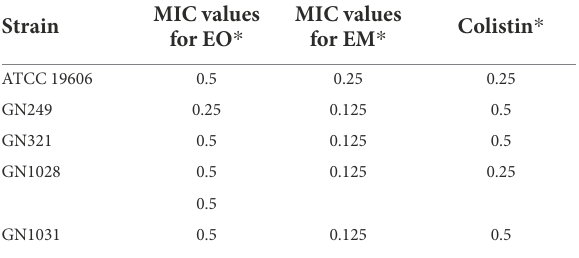
TABLE 3 Minimal inhibitory concentration values of cinnamon essential oil and cinnamon emulsion for Acinetobacter baumannii